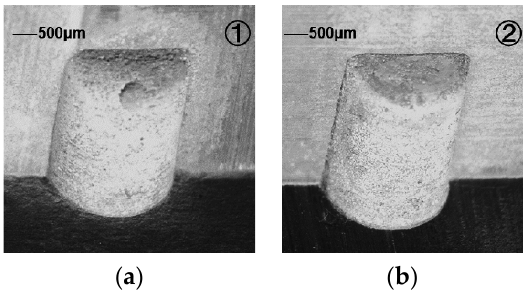
Figure 11. Effects of with/without short-circuit detection on machining: ( a ) without short-circuit detection; ( b ) with short-circuit detection.